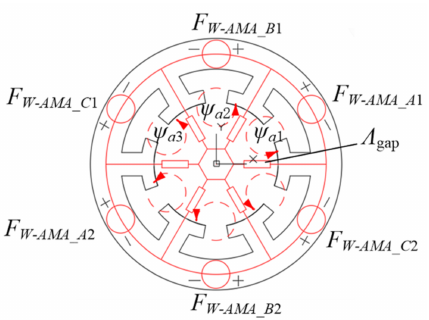
Figure 10. Armature reaction magnetic circuit model for AMA-FRPM